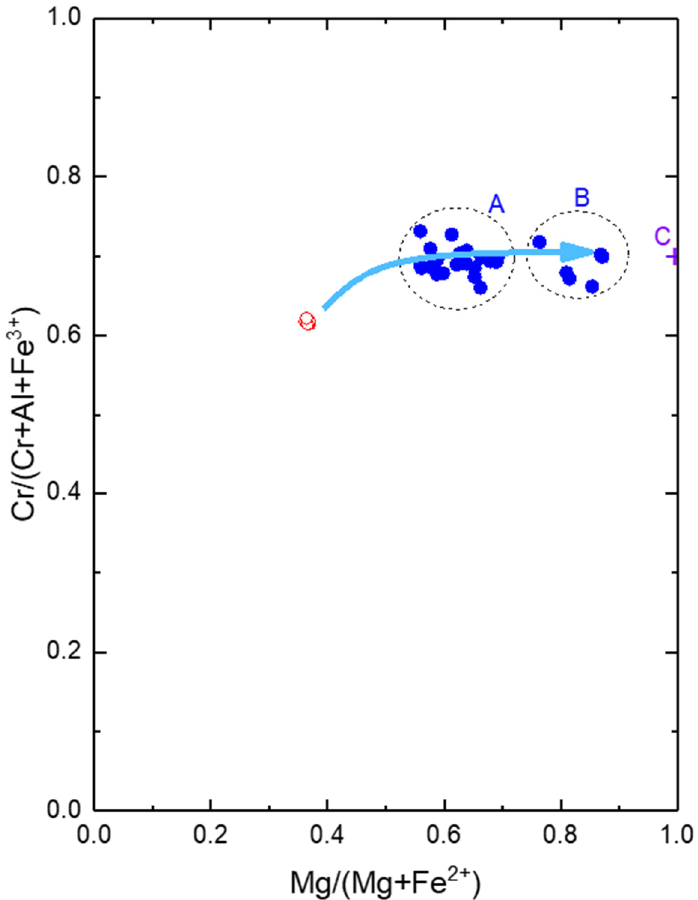
Figure 6. Changes in the composition of chromite resulting from reduction by hydrogen (blue symbols grouped as A and B with average chromite formulas of Mg 0.6 Fe 0.4 Cr 1.4 Al 0.6 O 4 and Mg 0.8 Fe 0.2 Cr 1.4 Al 0.6 O 4 , respectively. Original untreated chromite compositions are shown by red circles with an average starting composition of (Mg 0.4 Fe 0.6 )(Cr 1.2 Al 0.5 Fe 0.3 )O 4 .